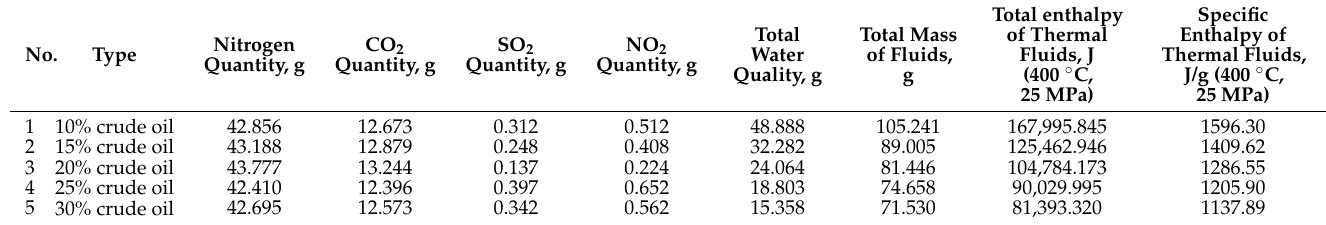
Table 11. Enthalpy of supercritical multi-thermal fluid generated by supercritical water-crude oil reaction under different oil-water ratios.